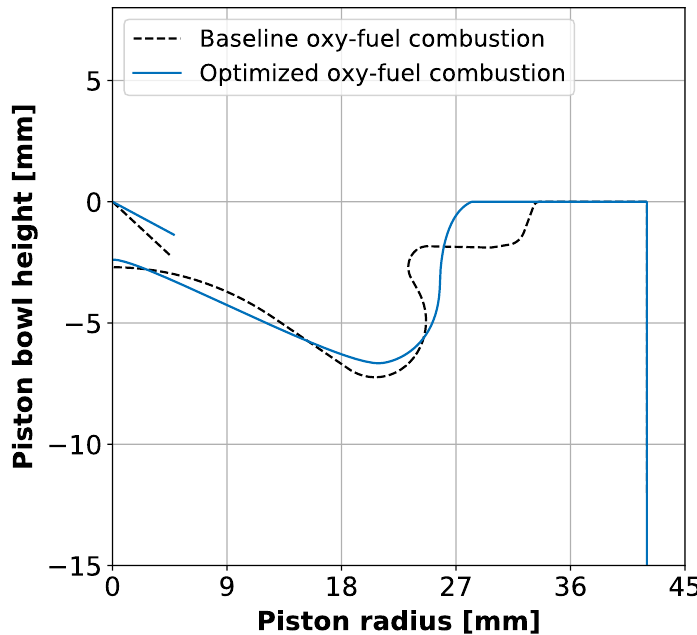
Figure 13. Comparison between the baseline and the optimized geometry.